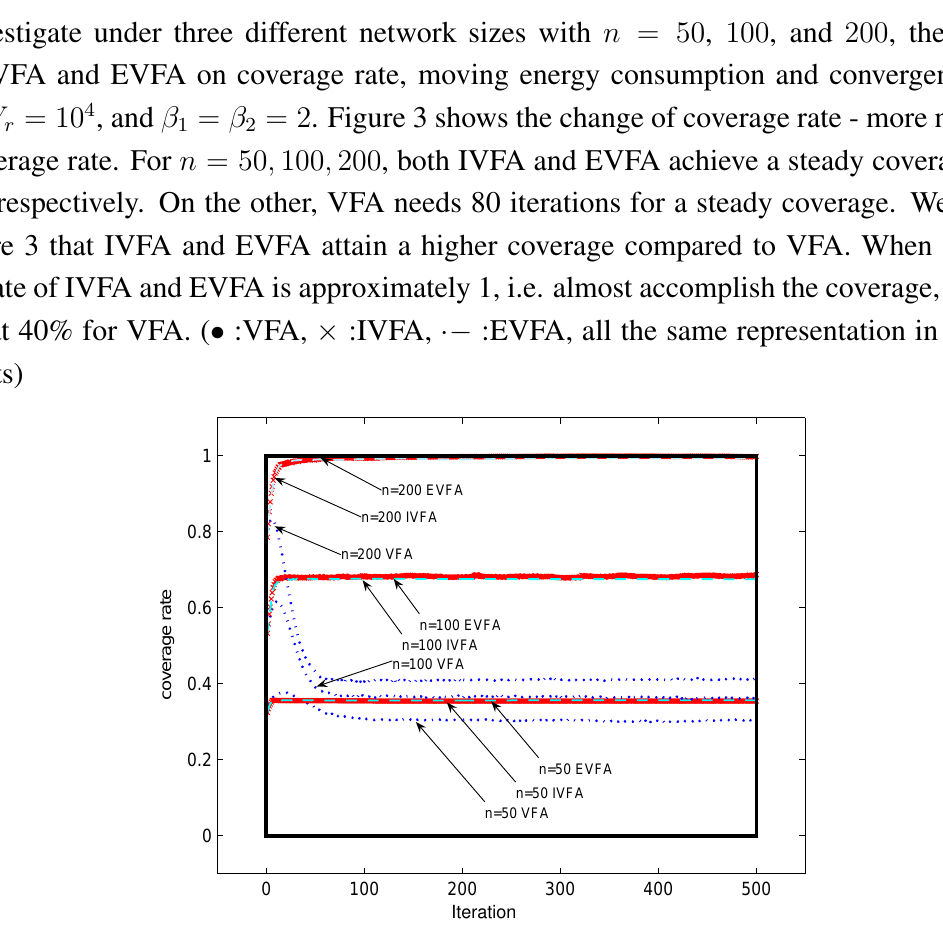
Figure 3 . C under VFA, IVFA, EVFA with different n r